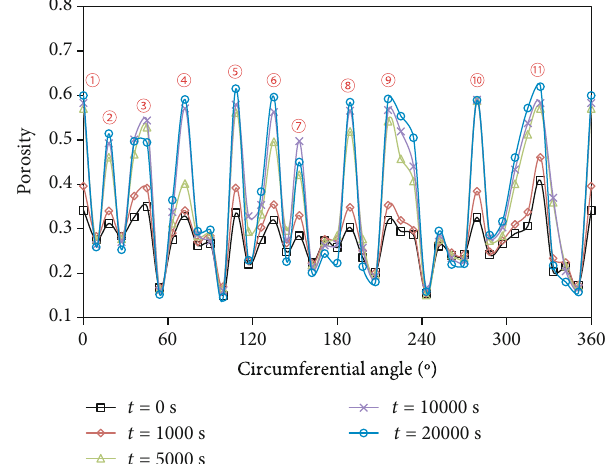
Figure 4: Pore pressure near the injection well at di ff erent times.